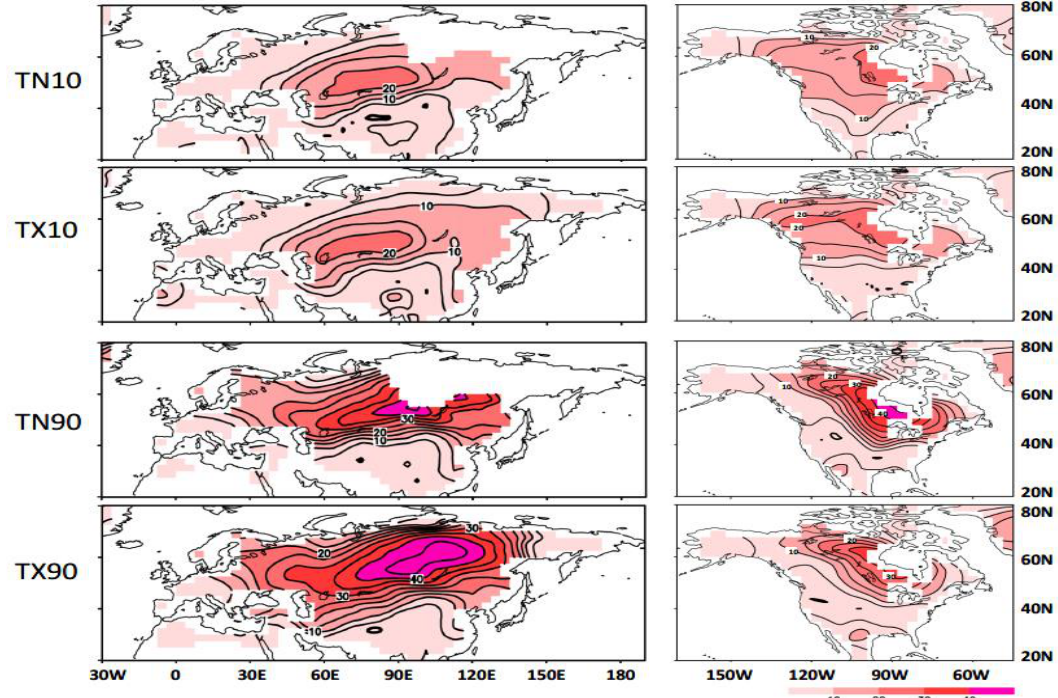
Figure 10. ( left ) Percentages of JFM extreme temperature anomalies explained by the linearly de-trended and standardized ensemble mean cyclone count series over Eurasia for the period 1951–2010. ( right ) Percentages of JFM extreme temperature anomalies explained by the linearly de-trended and standardized ensemble mean cyclone intensity series over North America for the period 1951–2010. Results of TN10, TX10, TN90, and TX90 are shown from top to bottom. Contour interval is 5%.